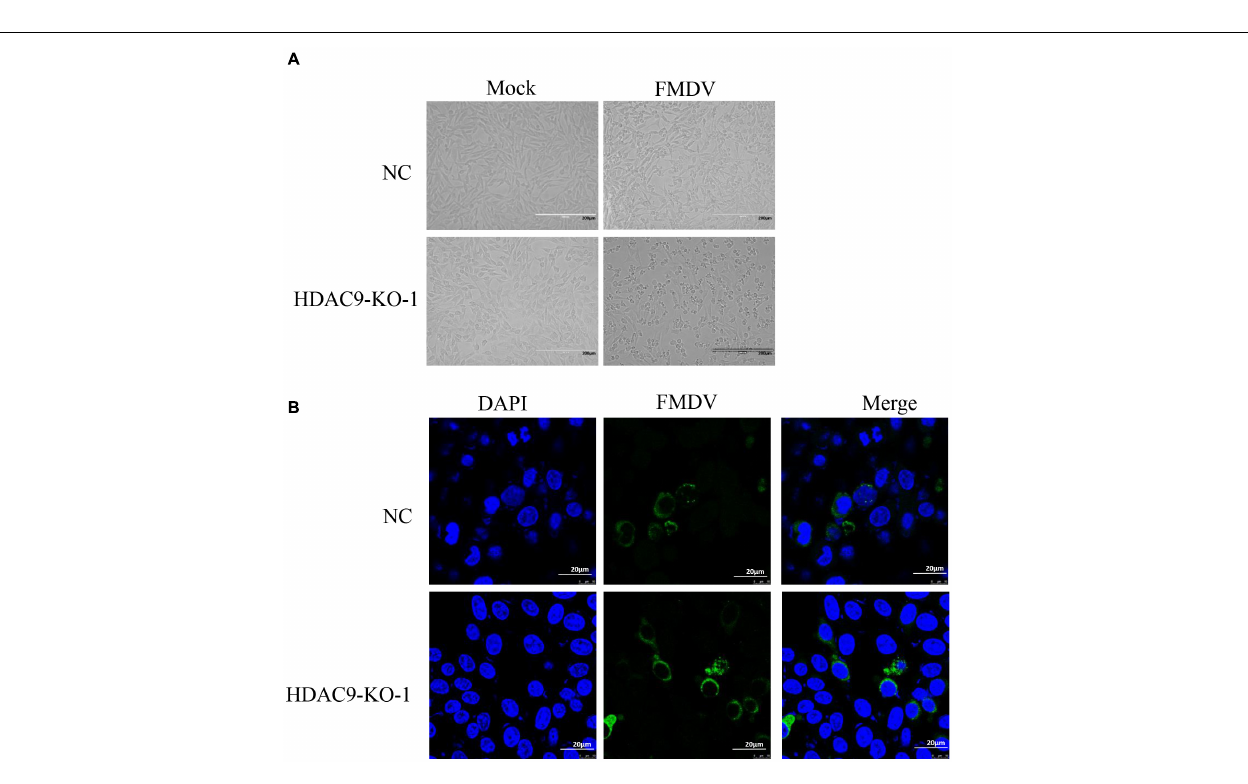
FIGURE 3 | Growth characteristics of FMDV. (A) CPE caused by FMDV, NC, and HDAC9-KO-1 cells was seeded in 6-well plates (2 × 10 6 cells/well) and were infected with FMDV at an MOI of 0.1 for 4 h. (B) Immunofluorescence assay of NC and HDAC9-KO-1 cells infected with FMDV. The cells were infected with or without FMDV at an MOI of 0.1. After 6 h, the signals of FMDV protein were observed under a confocal microscope. Green signals represent FMDV and nucleus was stained with